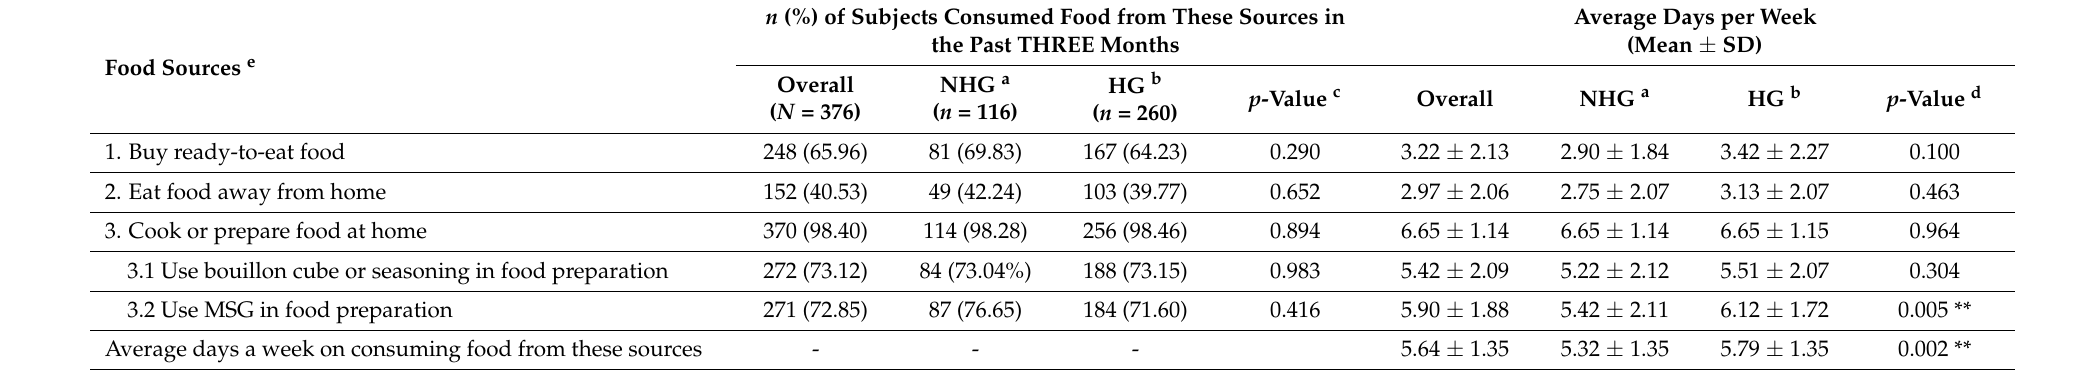
Table 5. High dietary-salt food sources associated with hypertension